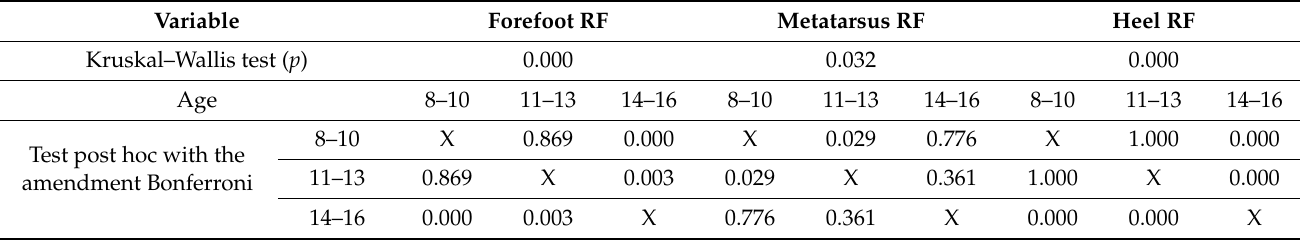
Table 4. Significance of differences in parameters of the distribution of pressure forces in the right foot between the studied age groups.